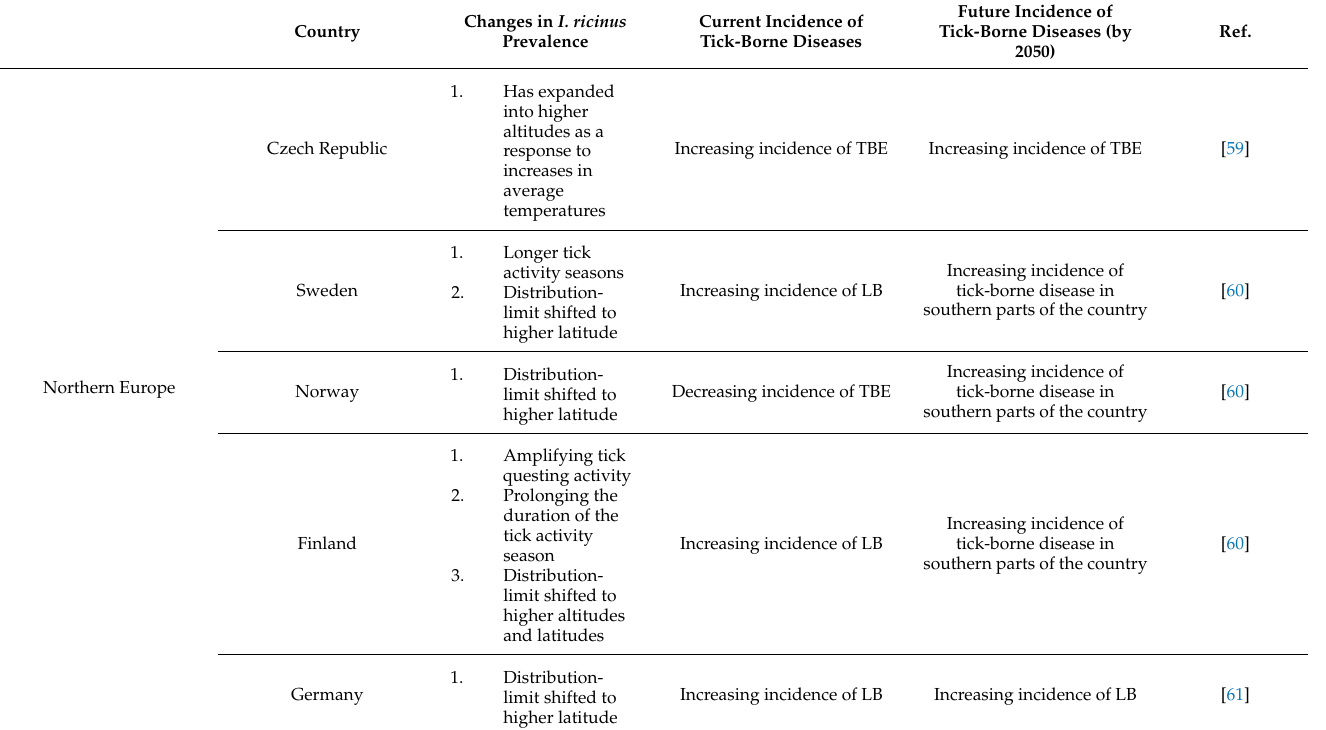
Table 1. Current and future state of the effect of climate change on I. ricinus prevalence and on tick-borne diseases in some European